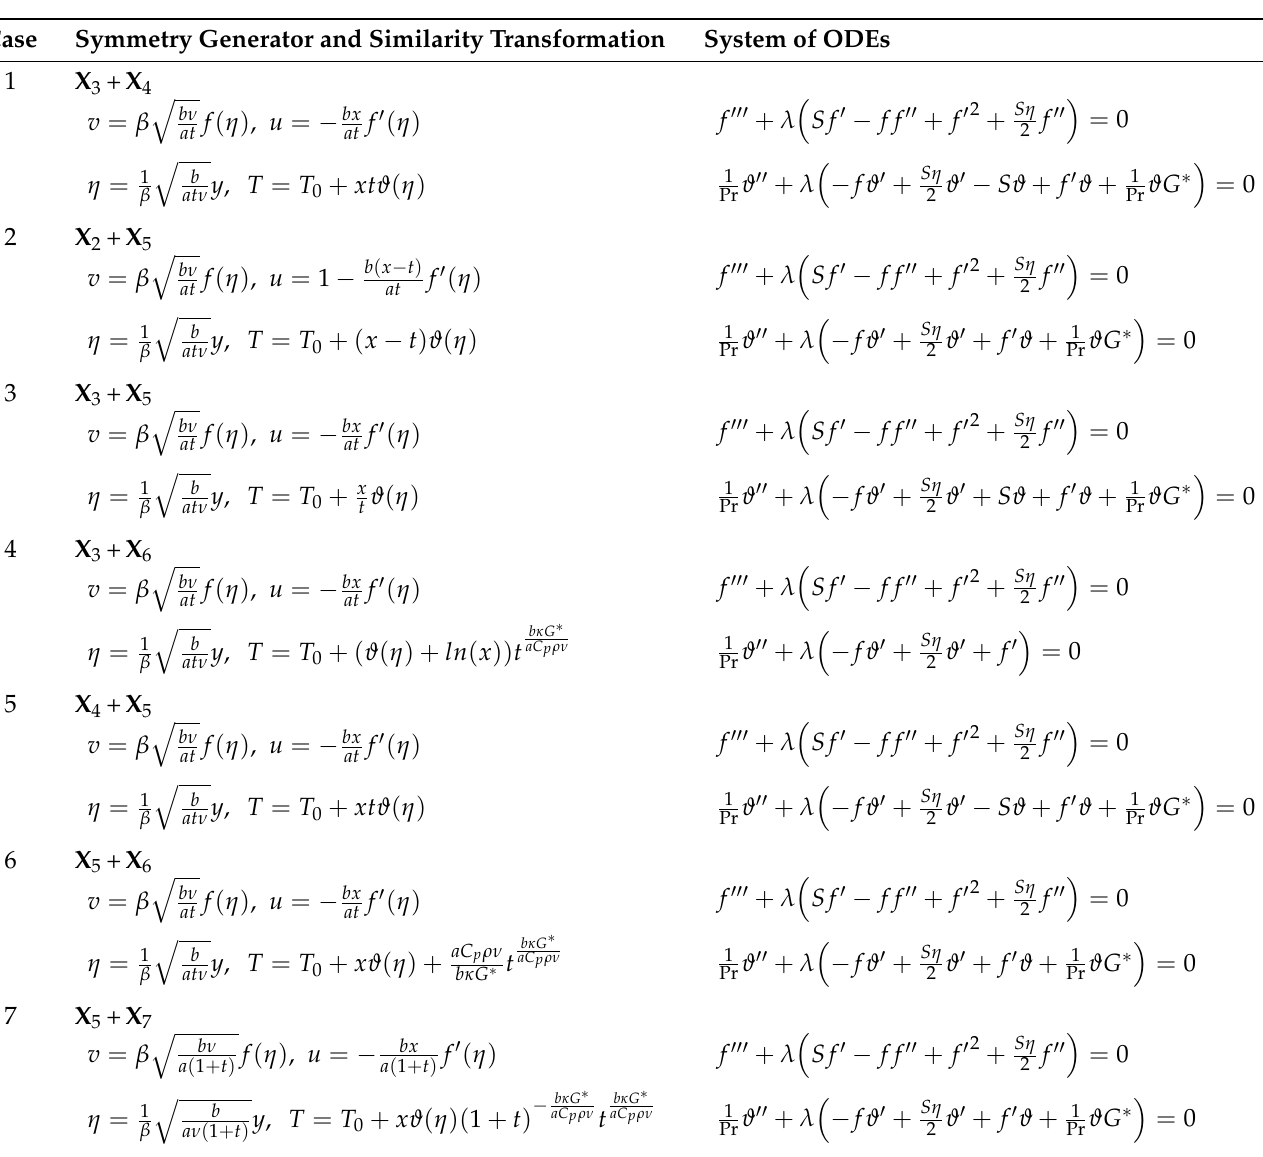
Table 3. Similarity transformations and systems of